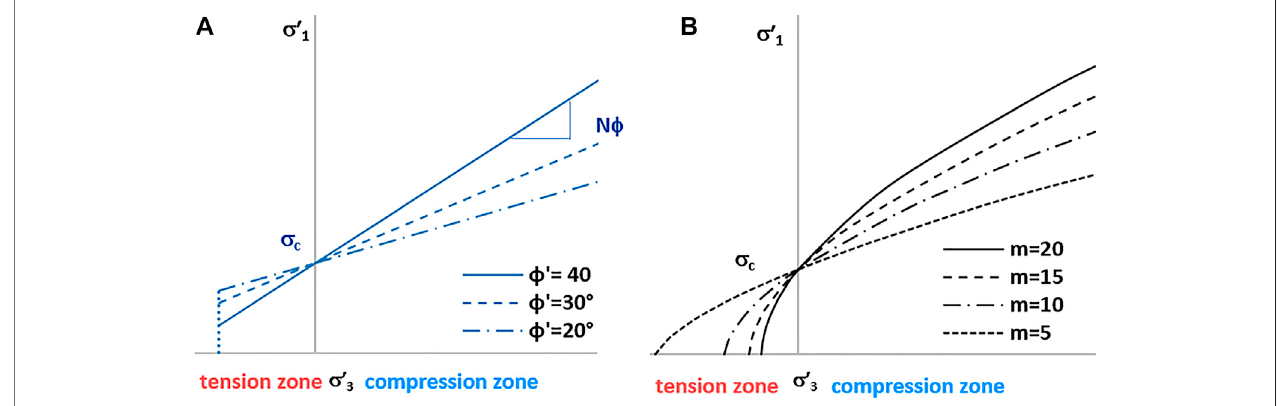
FIGURE 1 | (A) The Mohr – Coulomb criterion calculated with different N ϕ . (B) The Hoek – Brown criterion calculated with different m